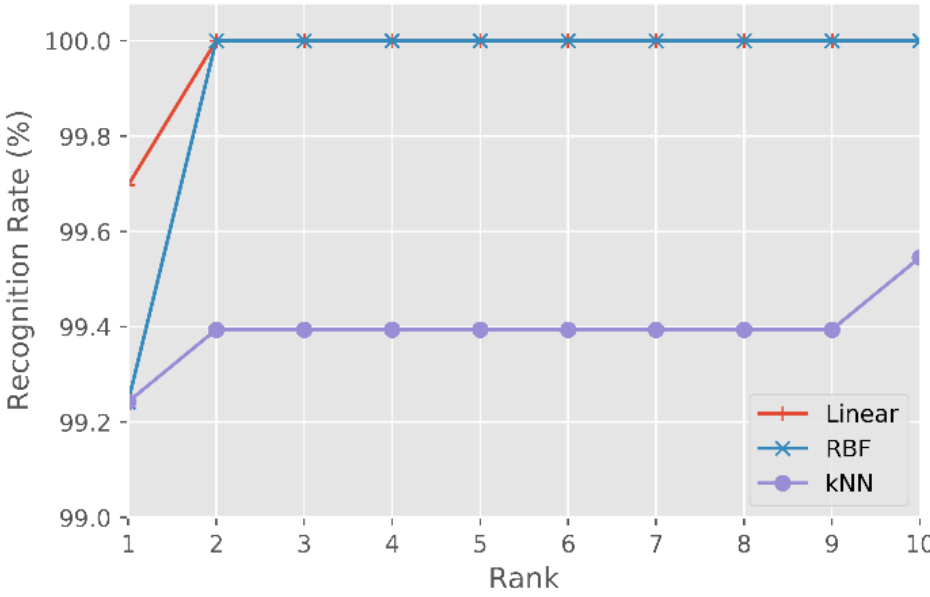
Figure 7. CMC curve for the SVM-Linear, SVM-RBF and kNN classifiers, for the Tufts multispectral database test set.